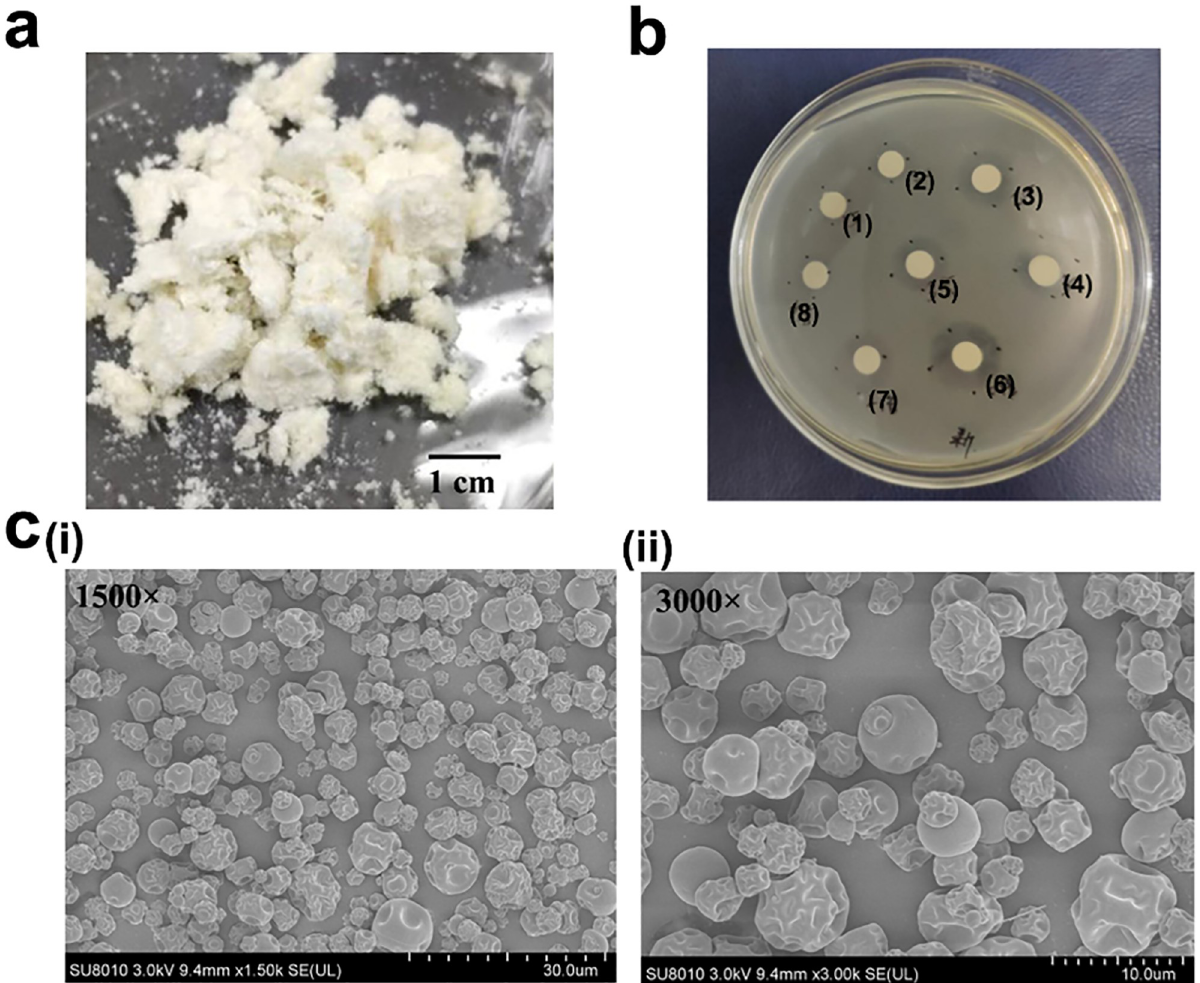
Fig 2. Characterization of microspheres. a Macroscopic observation of CMs(GM). b The antibacterial activity of the CMs(GM). (1)—(5) represent paper disks contained 15, 20, 25, 30, and 35 μ g mL -1 GM, respectively. (6)—(8) represent disks contained 1-fold, 2-fold and 4-fold dilutions of CMs (GM) leachate. c SEM images of CMs(GM) with (i) scale bar = 30 μ m and (ii) scale bar = 10 μ m. (CMs: Chitosan microspheres; GM: Gentamycin; β - TCP: β -tricalcium phosphate; SEM: Scanning electron